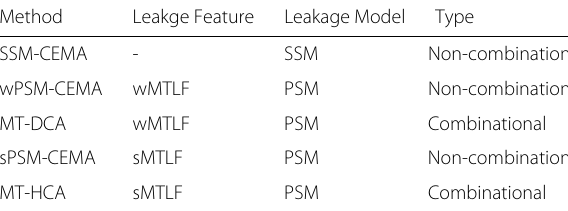
Table 1 Multi-thread combinational methods and